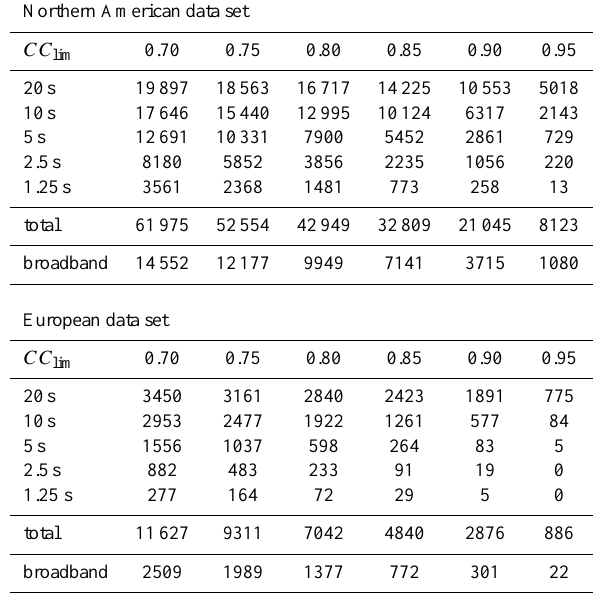
grams were available.